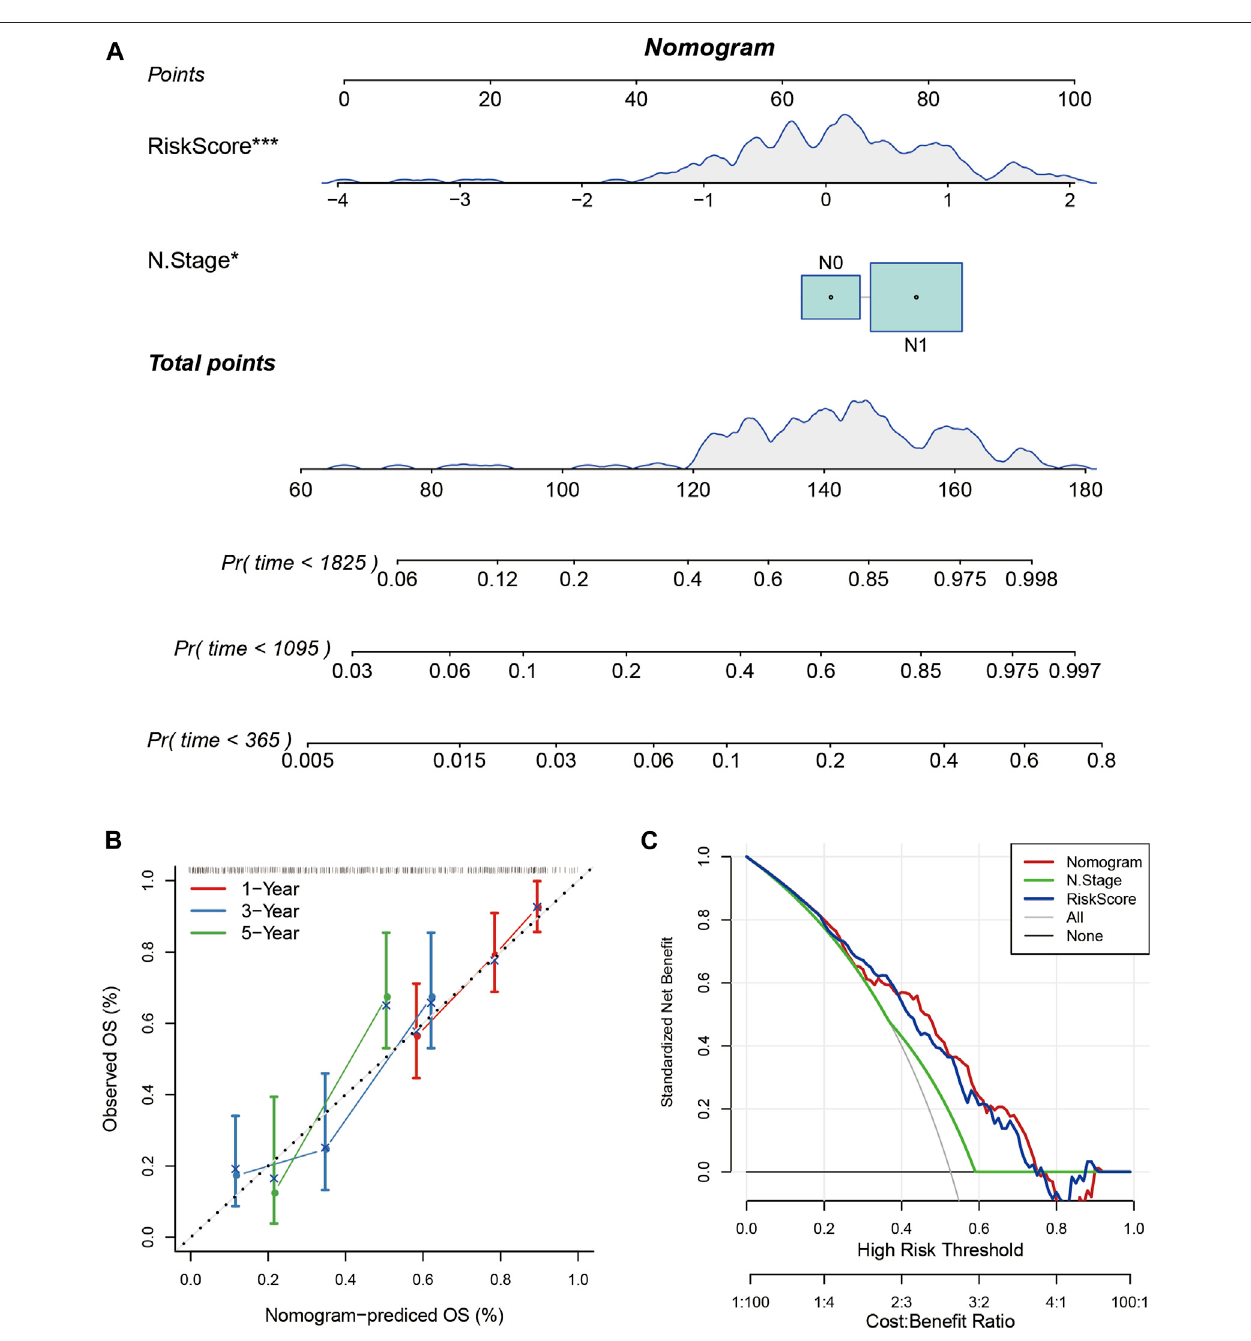
FIGURE 11 | (A) The nomogram model based on RiskScore and N stage; (B) The calibration plot of the nomogram; (C) The decision curve analysis of the nomogram model.